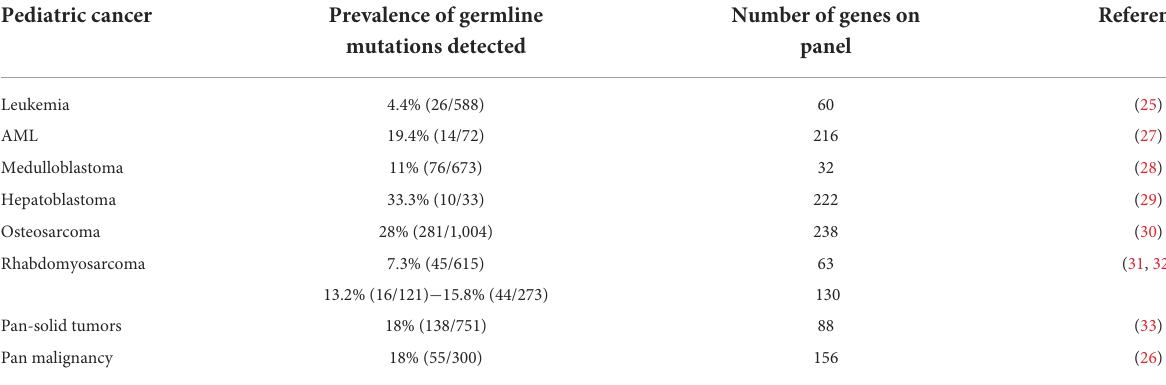
TABLE 2 Prevalence of germline cancer mutations detected in common pediatric